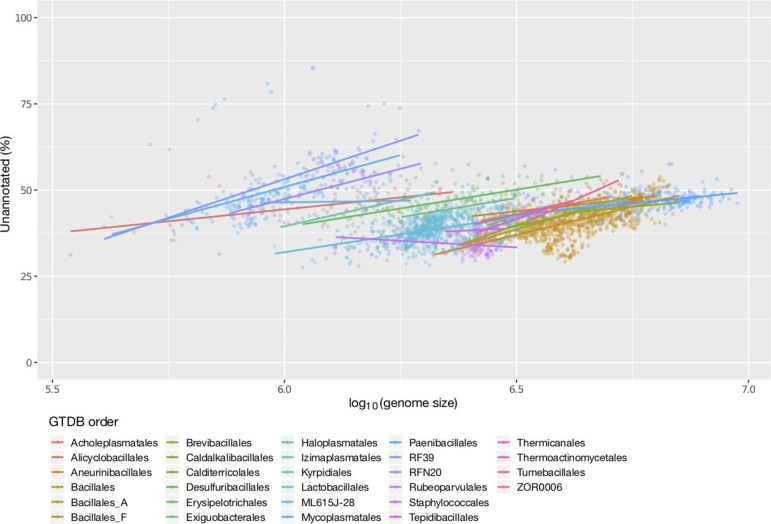
Prokka genome annotation coverage of
Firmicutes
 (GTDB taxonomy) against genome size. Trend lines are displayed for each taxonomic order.